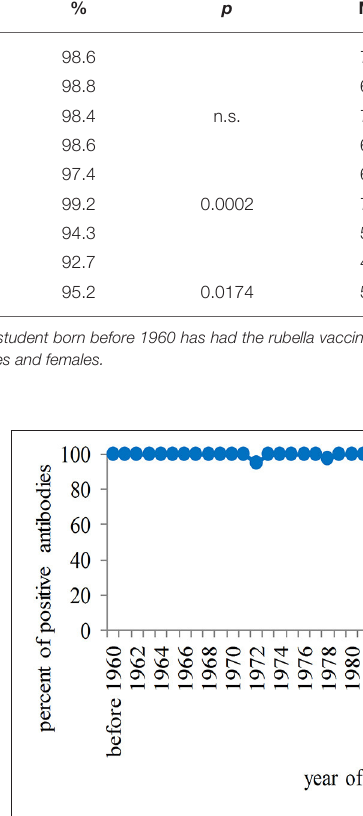
FIGURE 3 | Percentage of seropositivity of antibodies against rubella in unvaccinated students in relation to the year of birth. The rate of positivity is high in students born before 1990 and progressively tends to zero in the population born after that year.